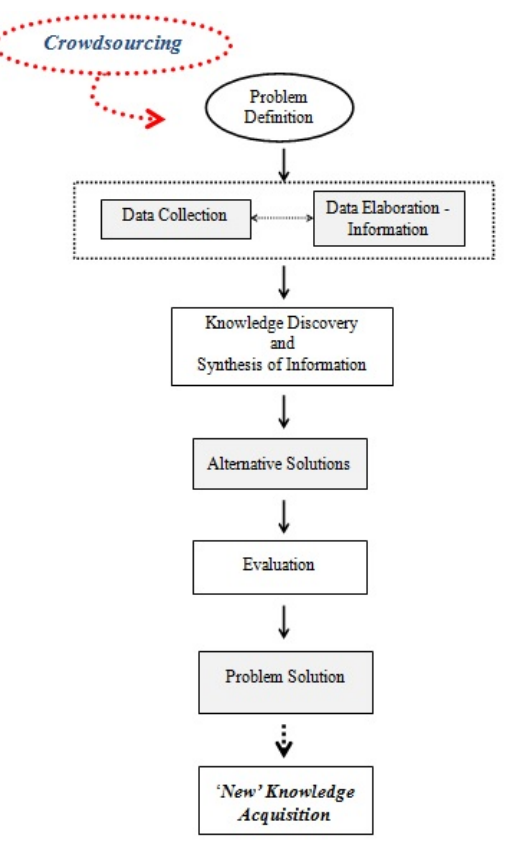
Figure 1. The concept of crowdsourcing for problem